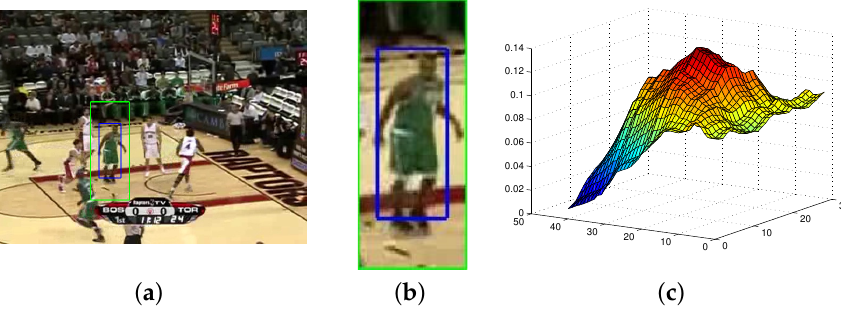
Figure 6. The maximum posterior probability of the target model. ( a ) 1st frame; ( b ) target candidate region; ( c ) the PPM of target